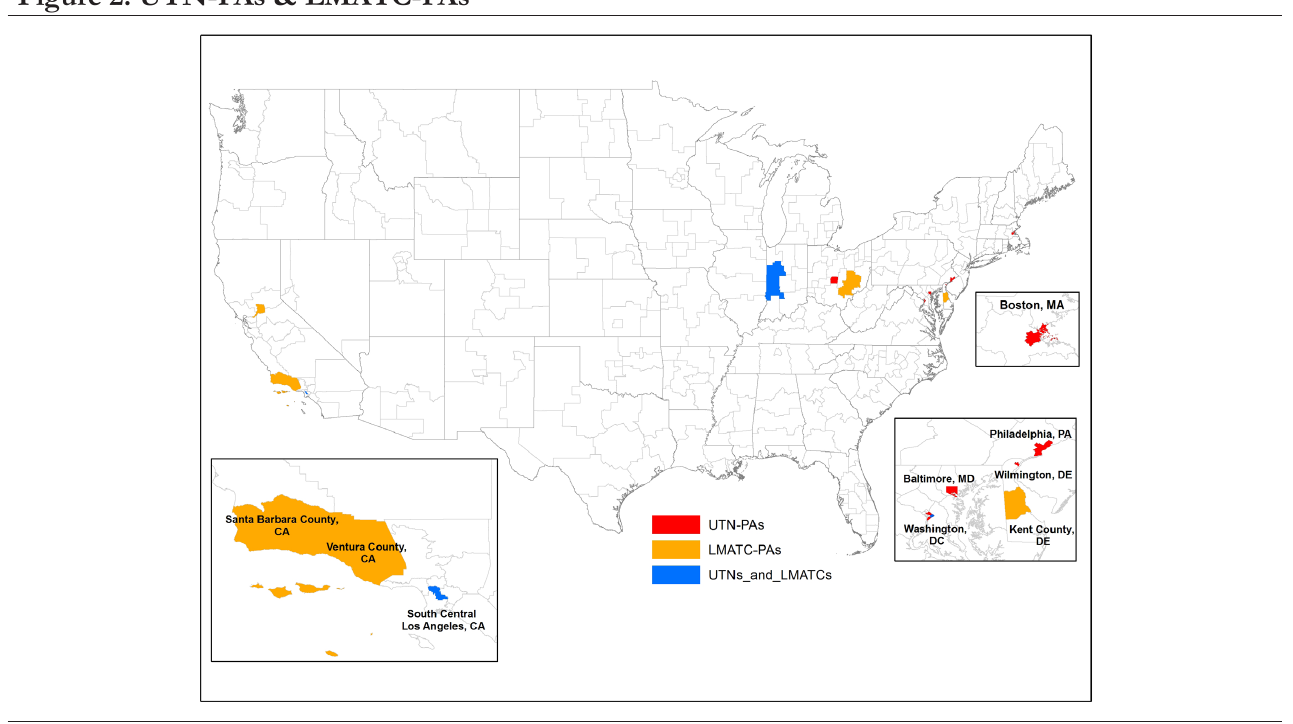
The UTN-PAs are shown in red. The LMATC-PAs are shown in orange, and the sub-state areas that were identified as both UTN- PA and LMATC-PA are shown in